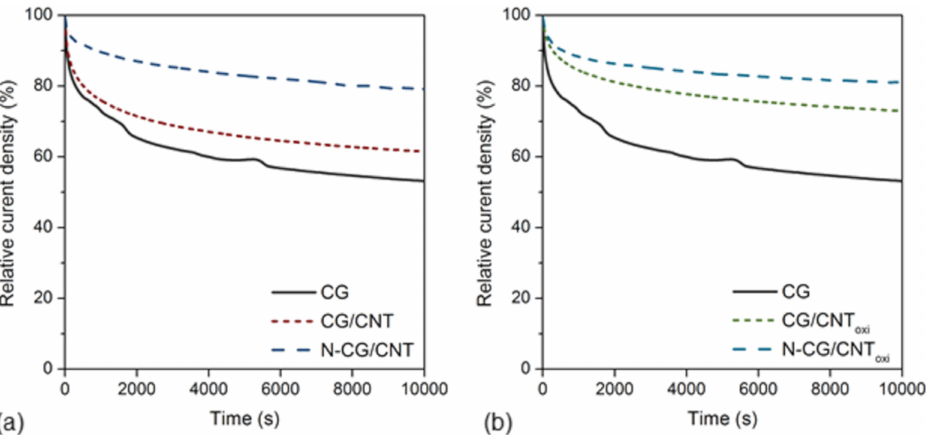
Figure 6. Chronoamperometry experiments measured at 0.4 V vs RHE for 10000 s for the carbonized glucose and the undoped and N-doped carbon composites prepared by introducing CNT ( a ) and oxidized CNT ( b